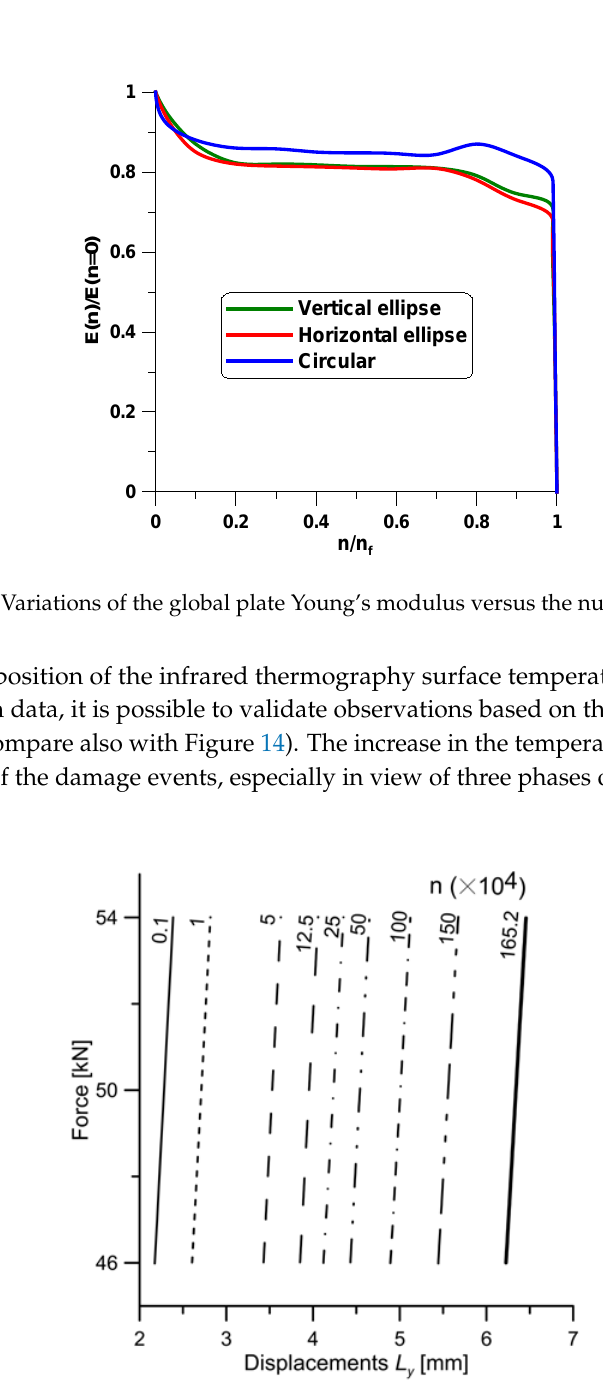
Figure 15. Global fatigue deformations of the plate with the vertical elliptical hole.